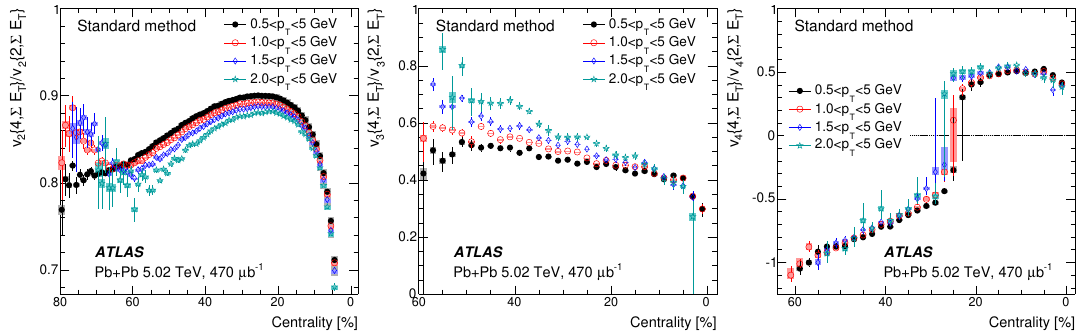
Figure 5 . The centrality dependence of cumulant ratios v n f 4 ; (cid:6) E T g =v n f 2 ; (cid:6) E T g for n = 2 (left panel), n = 3 (middle panel), and n = 4 (right panel) for four p T ranges. The error bars and shaded boxes represent the statistical and systematic uncertainties, respectively. Zero is indicated by a dotted line.